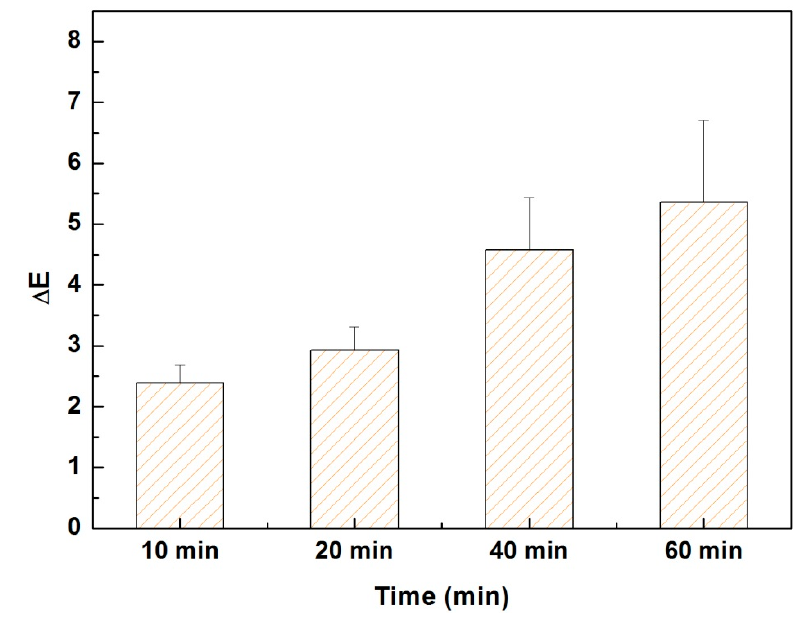
Figure 11. Evolution of color difference ( ∆ E ) of methylene blue dyed (PDADMAC/PAA) 2.5 -PET fabric with increasing time after exposure in UV light.